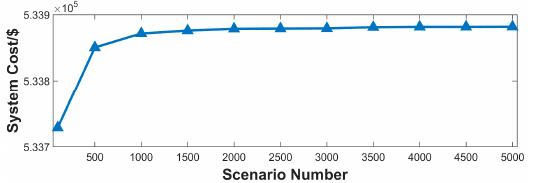
Figure 8. Objectives with different values of scenario number.